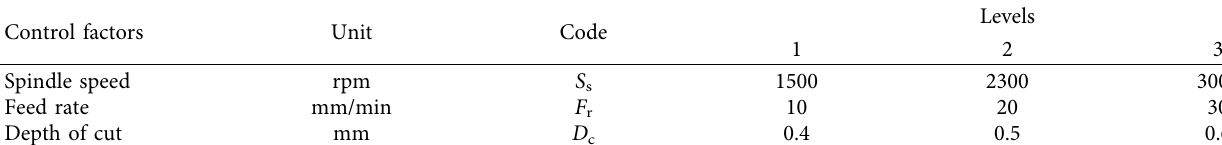
Table 2: Machining parameters and their